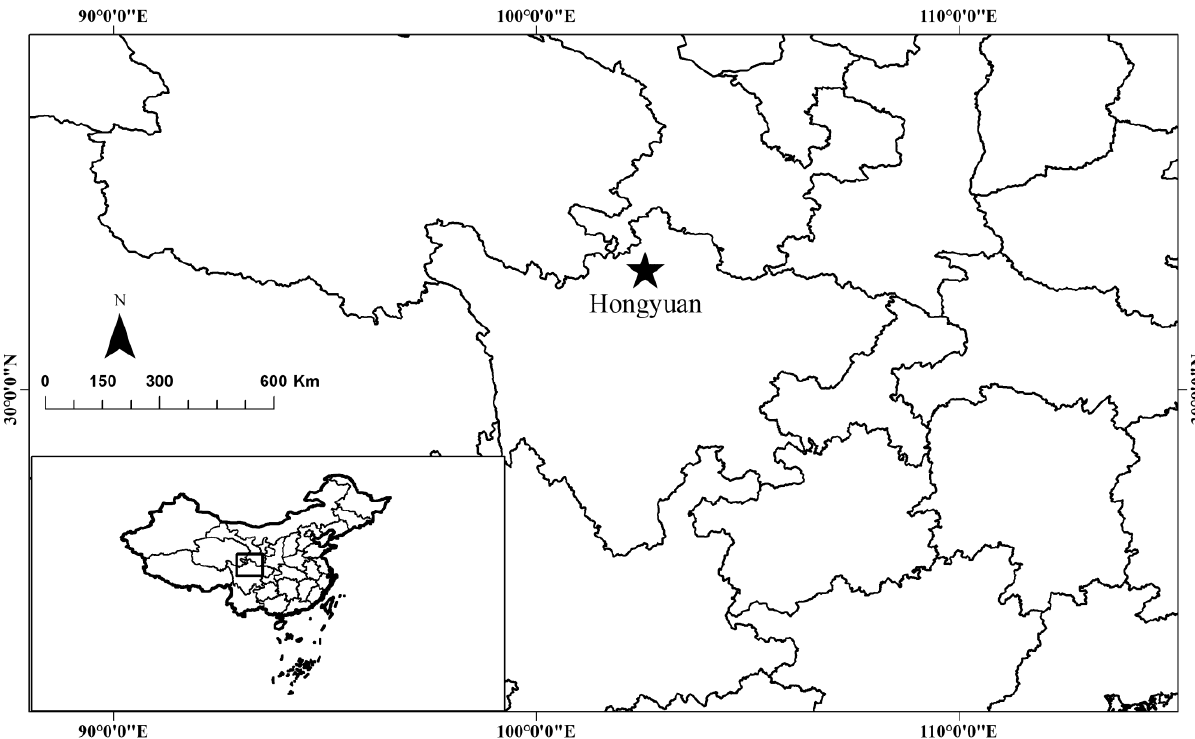
Figure 1. Site location for this study, Hongyuan County, Zoige peatland, China.